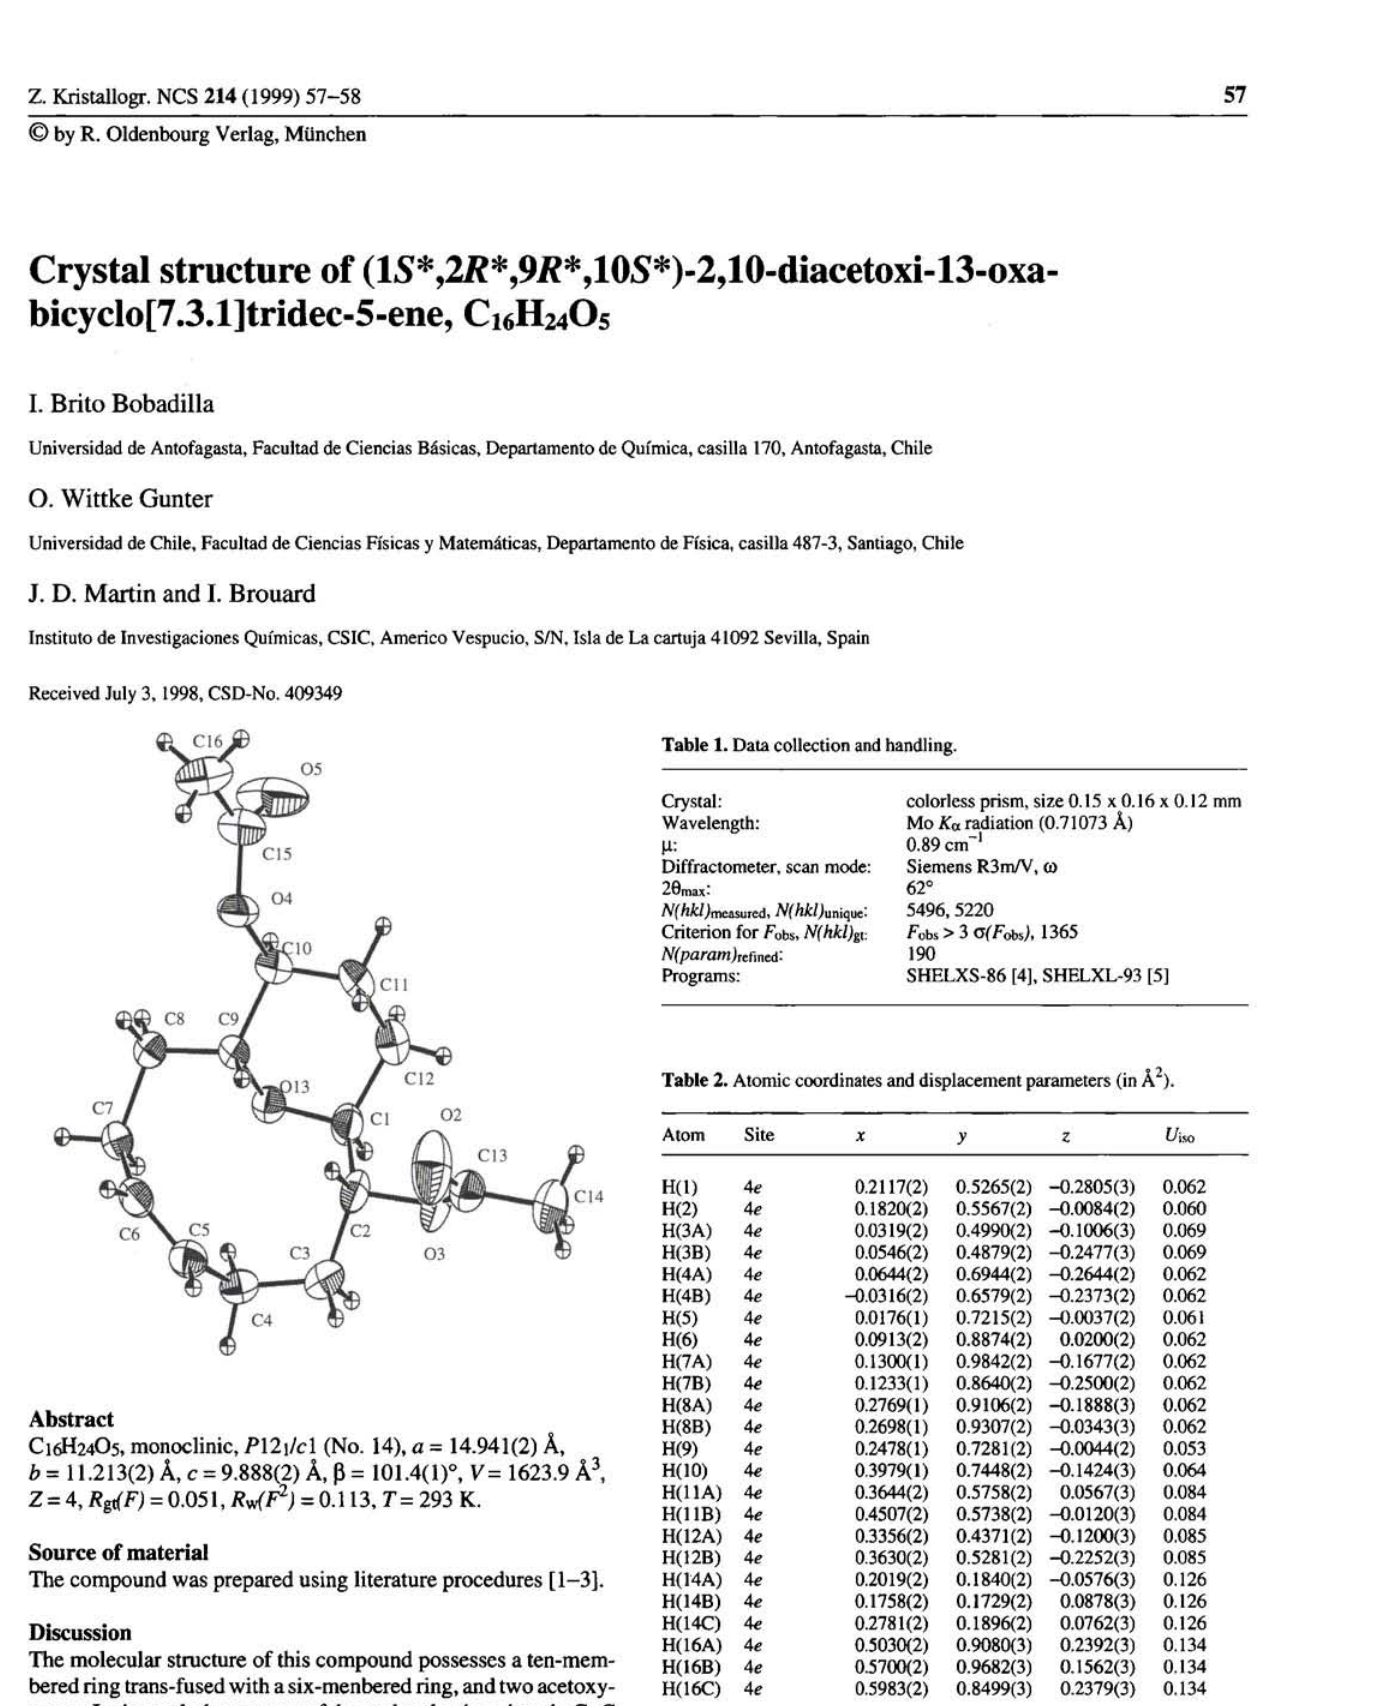
Table 2. Atomic coordinates and displacement parameters (in Â 2